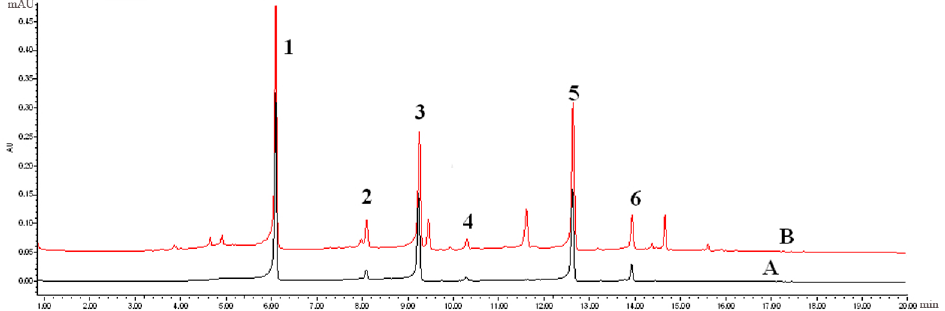
Figure 3. Typical UPLC-PDA chromatograms of mixed standards ( A ) and samples ( B ).